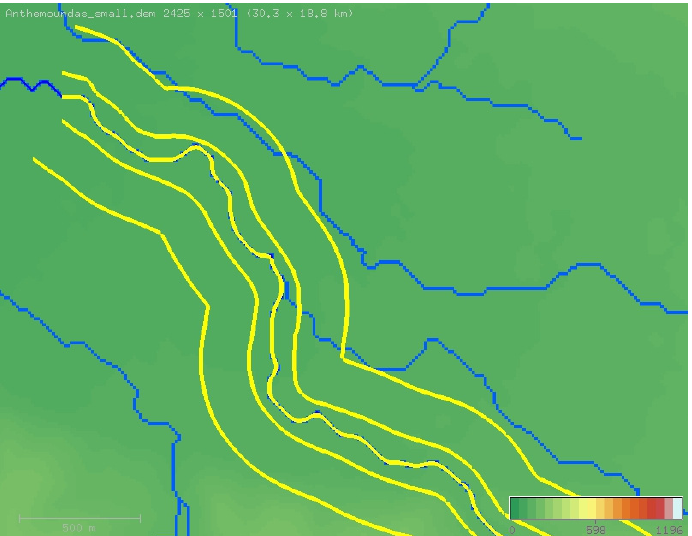
Figure 21. The stream, the banks, and the overbanks.